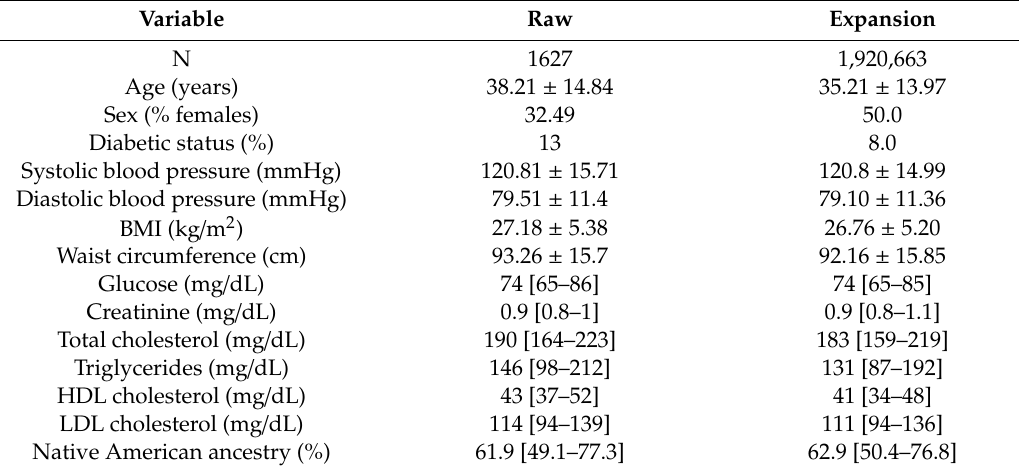
Table 1. Sample description.